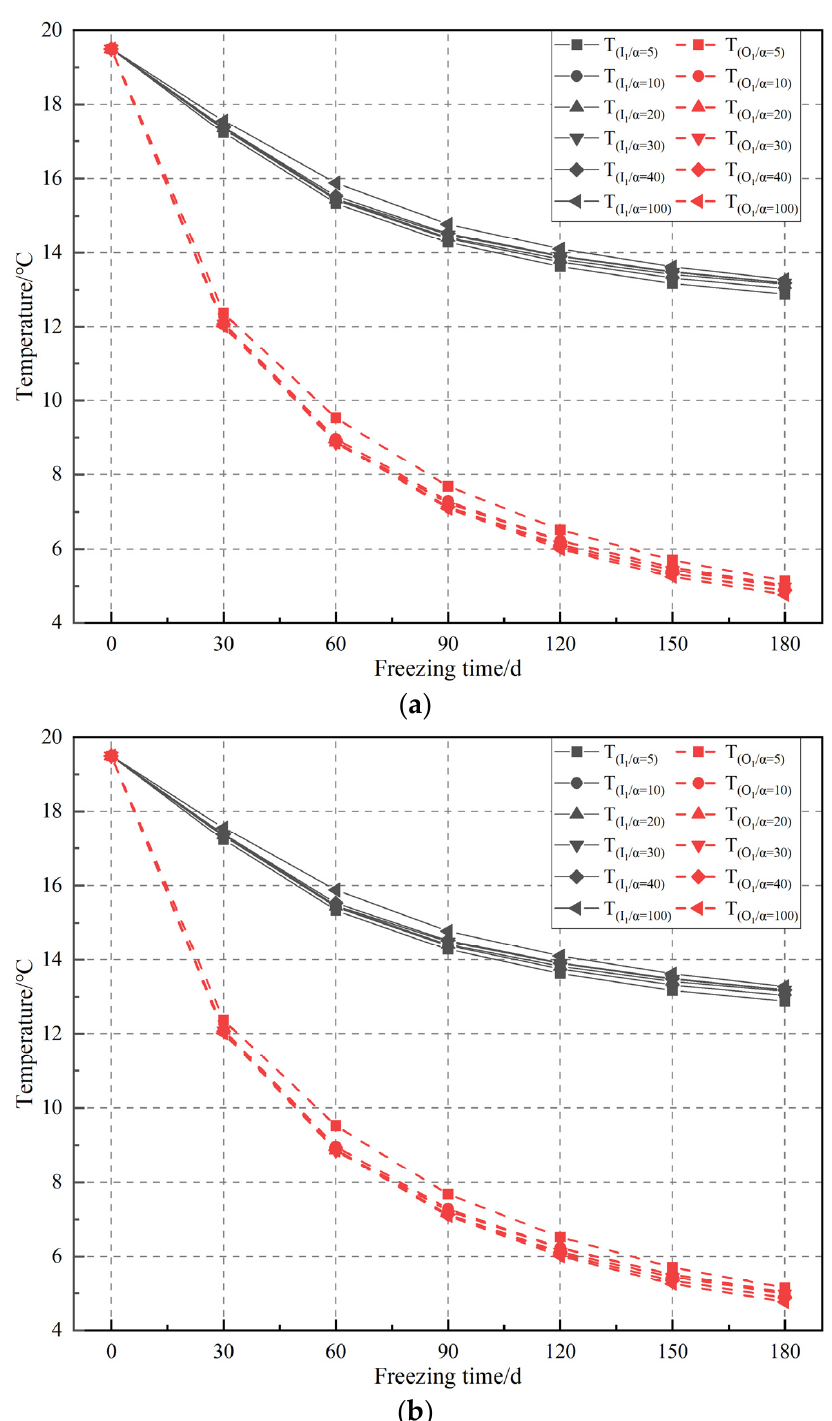
Figure 8. Variance in temperature and thickness under convective heat transfer coefficient of 30 W ∙ m − 2 ∙ °C − 1 and different freezing time: ( a ) temperature in interlayer and outside wall of shaft, ( b ) temperature and thickness in the inside and outside of frozen soil wall and its average or sum value with convective heat transfer coefficient of 30 W ∙ m − 2 ∙ °C − 1 .